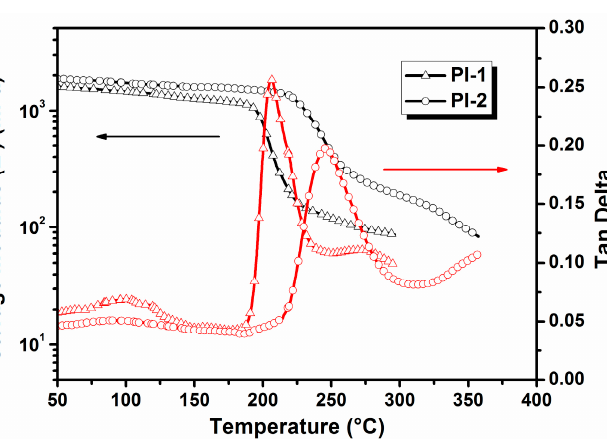
Figure 12. Dynamic mechanical thermal analysis (DMA) curves for polyimides.